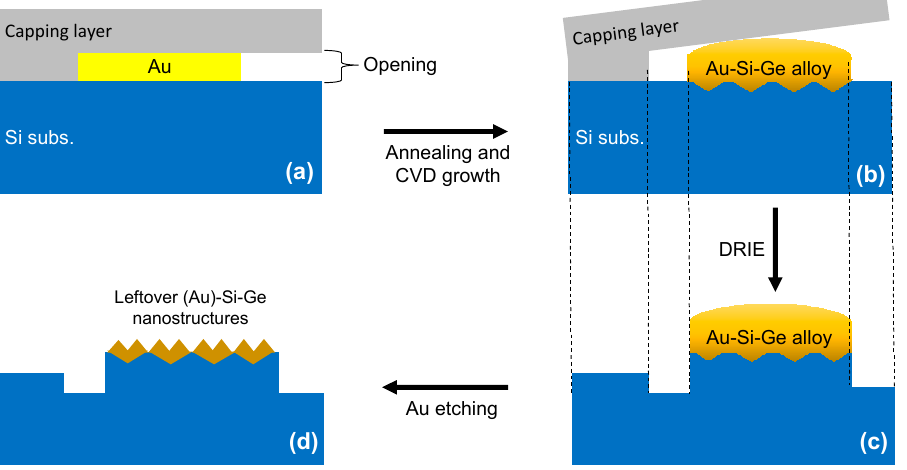
Figure 1. Cross-sectional schematics of the sample preparation process. ( a ) A micro-crucible structure that acted as the growth template where the micro-scale Au seed was placed under a capping layer (made of SiO 2 /Si 3 N 4 ) with a well-defined “opening.” ( b ) After annealing at a temperature higher than the Au-Si eutectic temperature of ≅ 363 °C for 15 min and then exposing the micro-crucible with 4 sccm of GeH 4 inside a CVD chamber (40 mTorr, 375 °C) for 1 h, a Au-Si-Ge eutectic alloy was formed inside the micro-crucible. At this point, the alloy/Si substrate interface would be rough as the underlying Si surface was dissolved during the eutectic formation. In addition, due to the agglomeration of the Au-Si-Ge eutectic liquid during this step, the capping layer was deformed and the alloy was displaced from its initial position. ( c ) Deep reactive ion etching (DRIE) for 18 min was carried out using SF 6 to physically remove the capping layer and expose the Au-Si-Ge alloy. The dashed lines indicate the height profile created from the DRIE. ( d ) The sample was then dipped into a Transene Gold Etchant TFA solution for 55 s to remove (the majority of) the Au species from the Au-Si-Ge alloy resulting in the exposure of some semiconductor nanostructures.